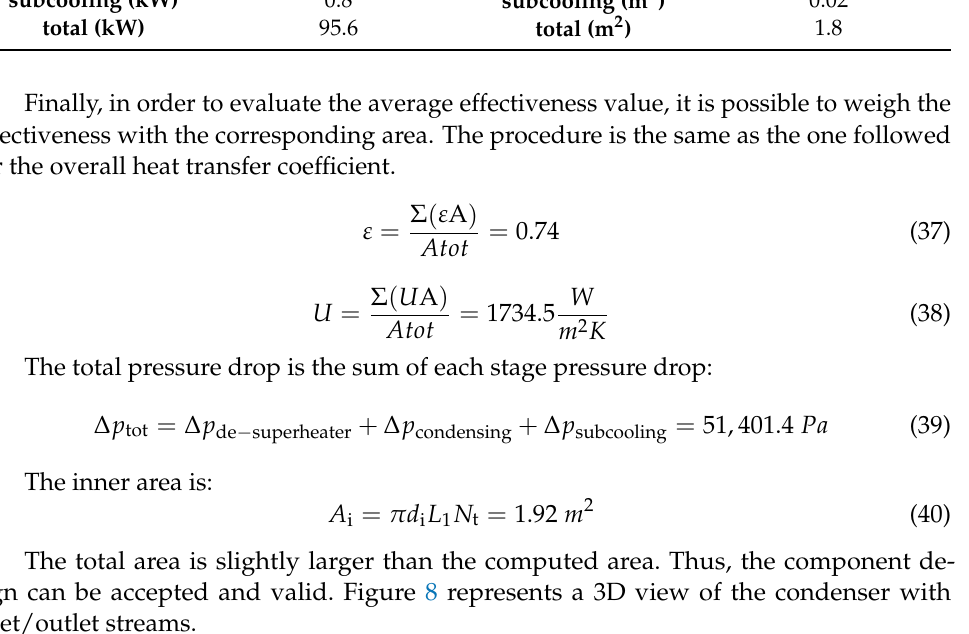
Figure 9. Commercial methane-fuelled vehicle (tanks in red) .